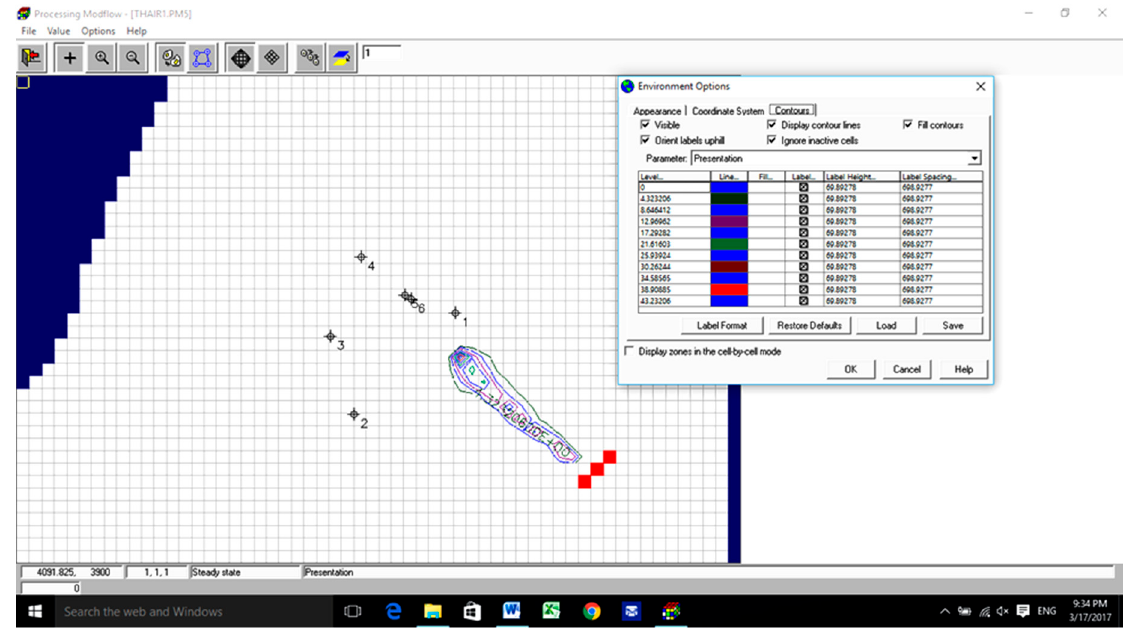
Figure 11. The extent of Co-60 pollutant concentrations from the LAMA area after 10 years for Scenario 2.